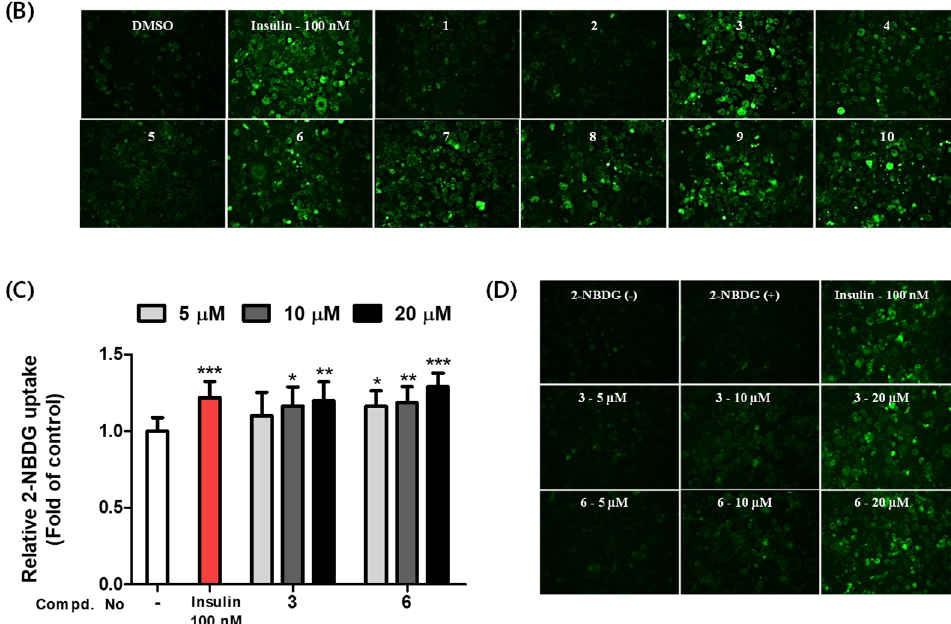
Figure 4. Stimulatory effects of compounds 1 – 10 on glucose uptake in 3T3-L1 adipocytes using a 2-NBDG. ( A ) 3T3-L1 adipocytes were incubated with insulin (100 nM) as a positive control and compounds 1 – 10 (20 µ M) for 1 h with or without 2-NBDG. Glucose uptake was measured at Ex/Em = 450/535 nm using a fluorescence microplate reader. The results are presented as the means ± SDs ( n = 3); each experiment was performed in triplicate. * p < 0.05, ** p < 0.01, and *** p < 0.001, compared to the negative control. ( B ) After differentiated cells were treated with 100 nM insulin and 20 µ M test compounds after treatment for 1h at the presence or absence of 2-NBDG, each cell image was obtained with a fluorescence microscope. ( C , D ) Concentration − dependent effects of compounds 3 and 6 on glucose uptake in 3T3-L1 adipocytes. Cells were treated with these compounds at 10 and 20 µ M or with 100 nM insulin. After 1 h of incubation, the fluorescence intensities images were obtained using fluorescence